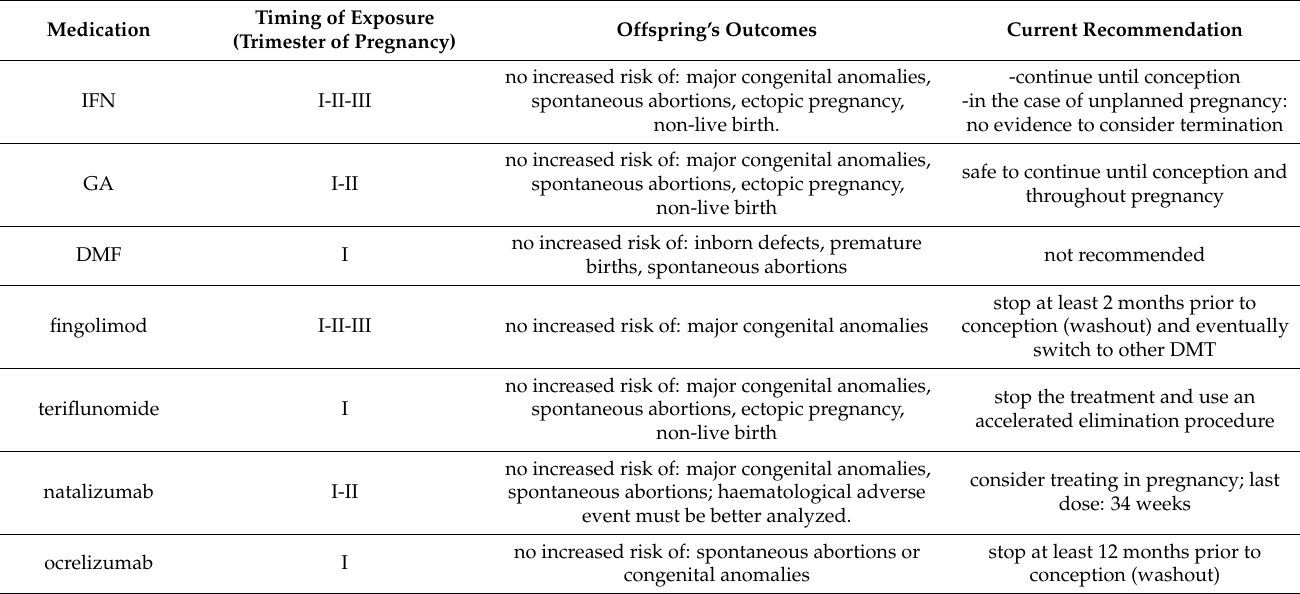
Table 1. Summary of the main knowledge (risk of adverse pregnancy outcome and recommendation) on the use of disease-modifying treatments (DMTs) during pregnancy (interferons (IFN),